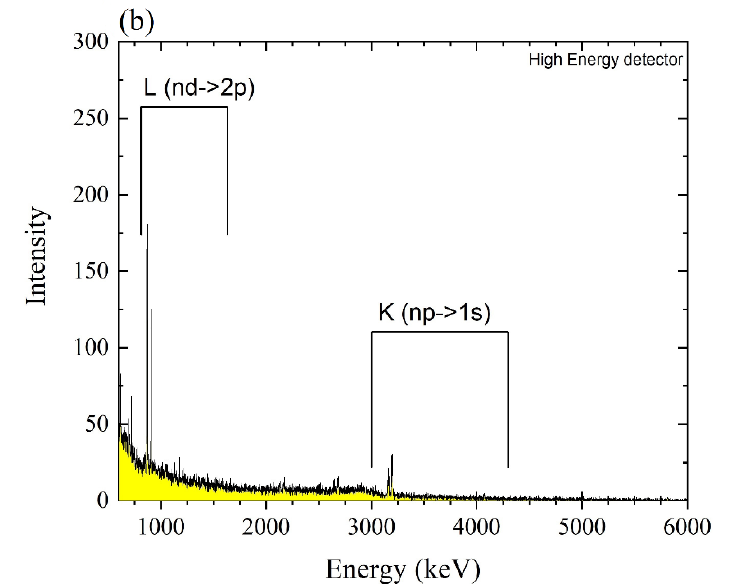
Figure 3. A typical pure silver spectrum. ( a ) With low energy detectors (up to 1 MeV), low energy transitions are detected. Since the muon travels to the nucleus across the energy states of the muonic atom, most of the transition can be detected; ( b ) high energy transition of silver. Data was taken and adapted from [16].